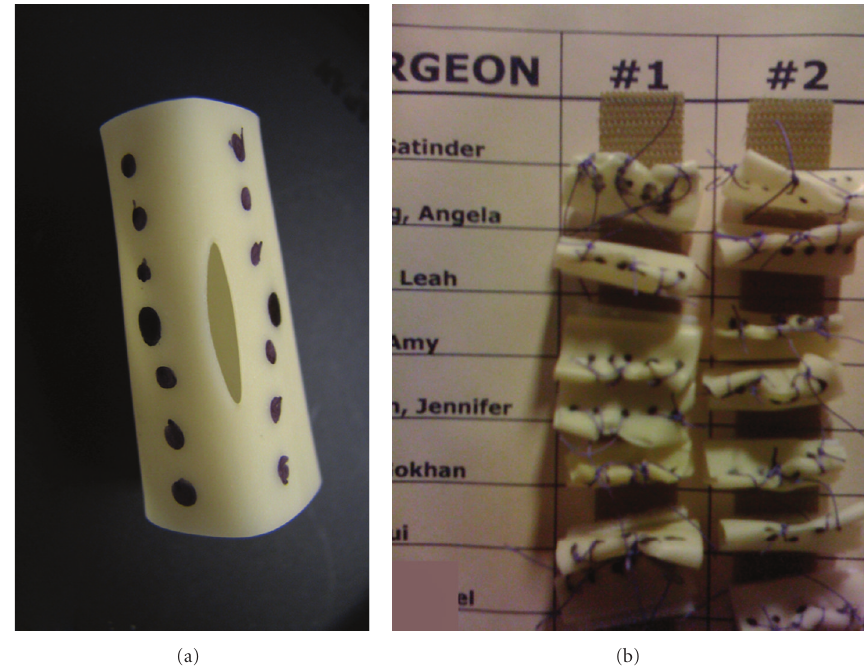
Figure 2: (a) This “Holiotomy” is marked with dots on each side, which surgeons must suture through in placing three “figure of N’s” and then tie each with four square knots. Thus, twenty-four sutures are passed through a dot, and at least twenty-four knots are tied. (b) Close-up of completed holiotomies on the